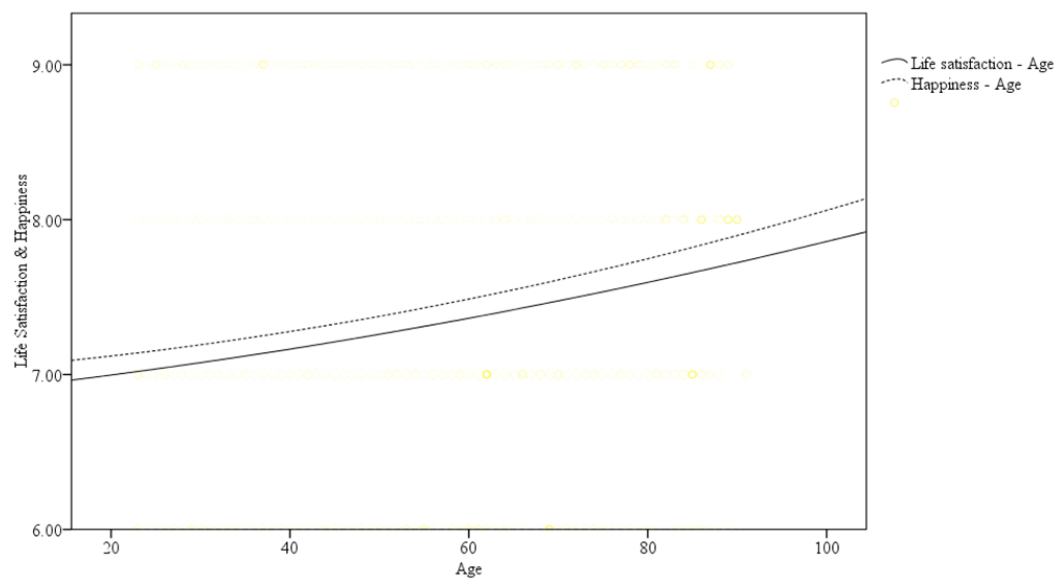
Figure 1. Estimated age patterns for life satisfaction in adults based on the three physical activity levels.